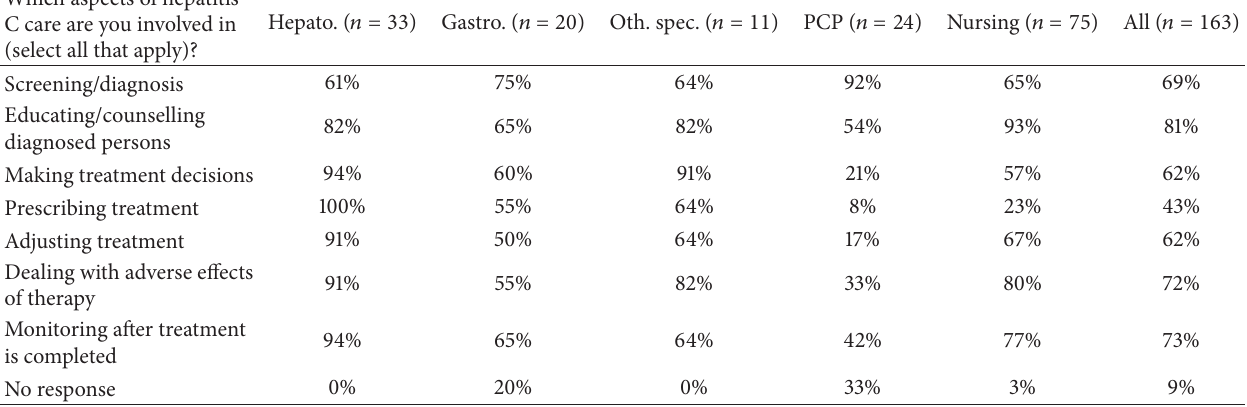
Table 1: Hepatitis C care delivered by